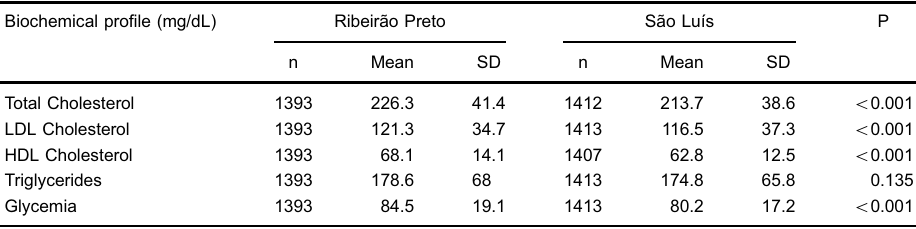
Table 5. Altered metabolic syndrome components in Ribeirão Preto and São Luís 2010 birth cohorts. Altered metabolic syndrome components Ribeirão Preto (n, %) São Luís (n, %) P Triglycerides ( X 150 mg/dL) 855